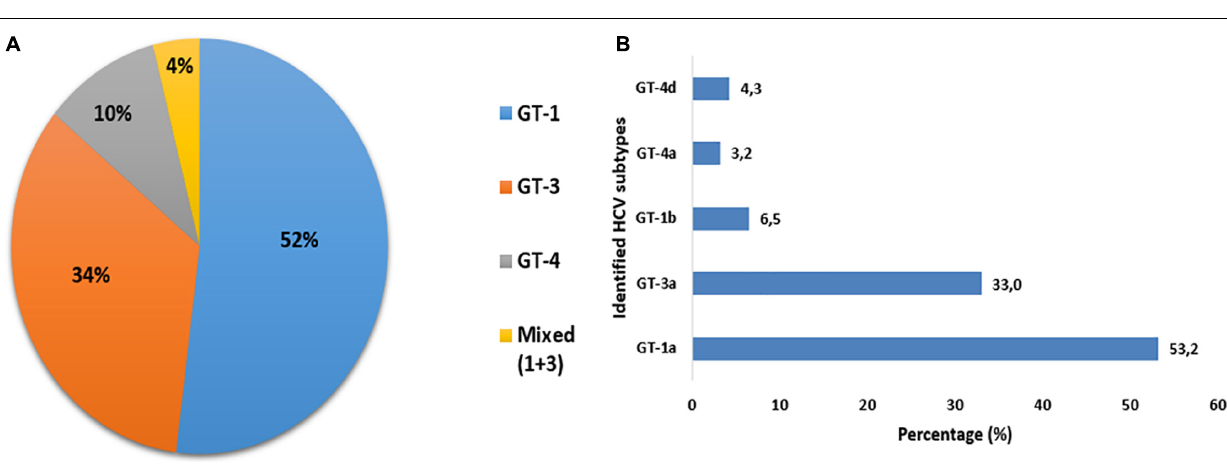
FIGURE 3 | Distribution of HCV genotypes (A) and subtypes (B) among PWID attending syringe services programs (SSPs) in the North Eastern region of